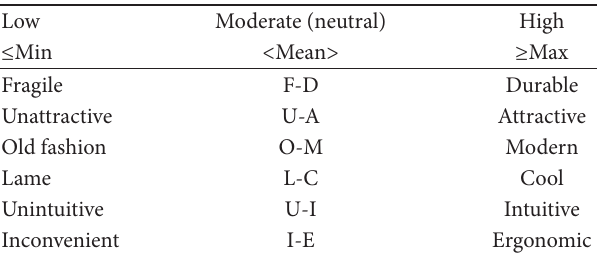
Table 13: Classification of Kansei words pairwise question into low, moderate, and